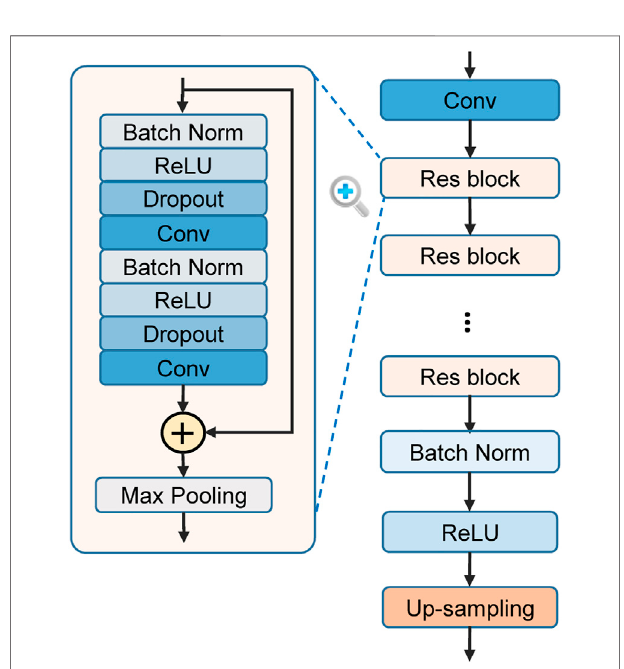
FIGURE 4 | The structure of residual convolutional network (ResNet) for featurelearning.Resblock =residualblock. Conv =convolutionallayer. Batch Norm = batch normalization. ReLU = recti fi ed linear